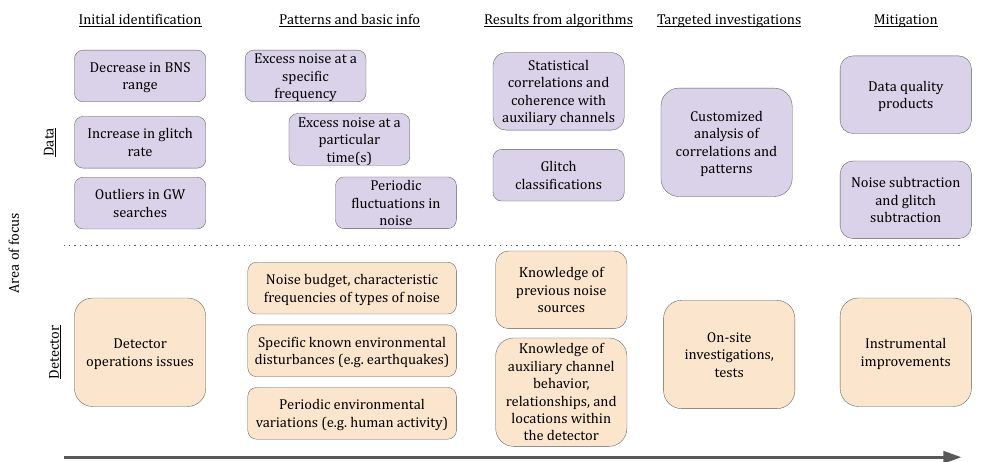
Figure 2. A summary of the general approach to investigating problems from a detector characteri- zation perspective. The two rows show the two main areas of focus in the investigation, either the detector or the data. Rows represent steps in the investigation, while boxes are individual methods. The typical investigation process proceeds from left to